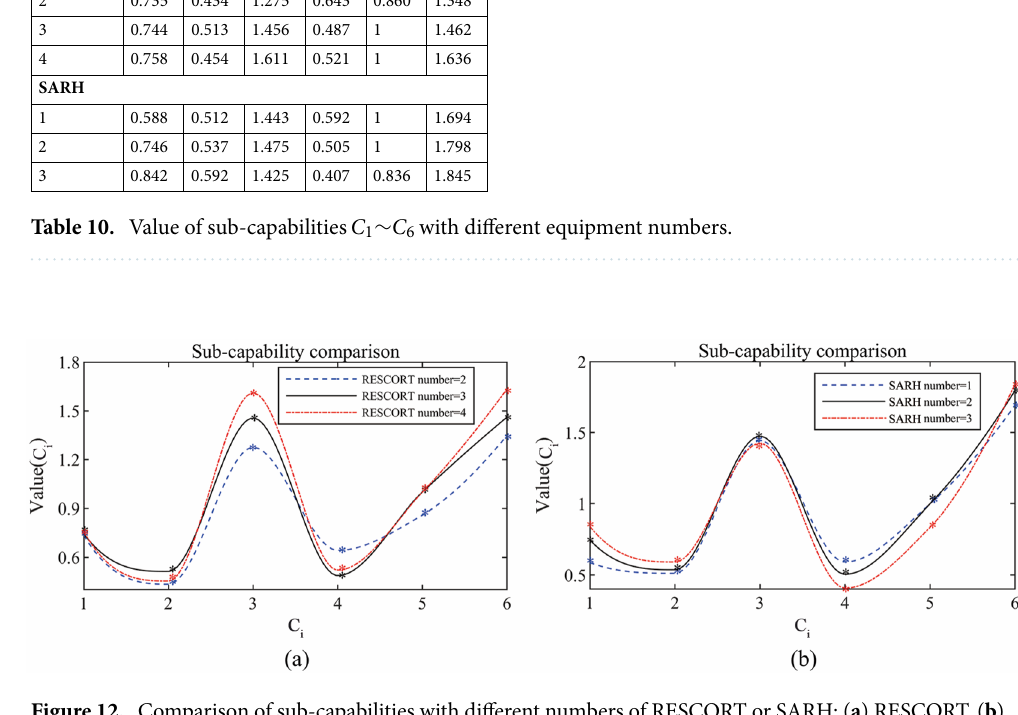
Figure 12. Comparison of sub-capabilities with different numbers of RESCORT or SARH: ( a ) RESCORT, ( b ) SARH.